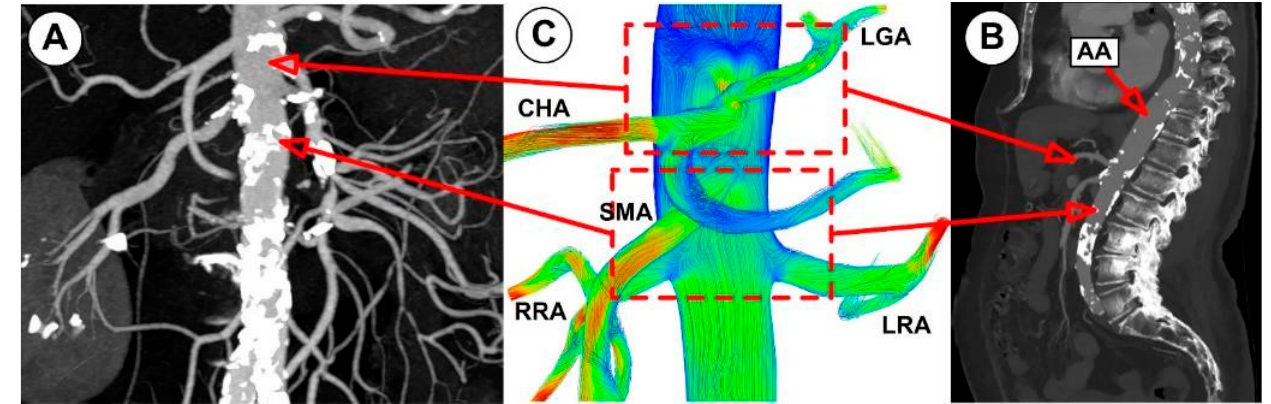
Figure 19. A CFD model was used to estimate the stenosis-prone area in the inferior aorta and its branches. ( A ) Anterior view of the inferior aorta segment with severe stenosis and calcification (patient A; ( B ) lateral view of the stenosed abdominal aorta (patient B); ( C ) flow field evolution predicted using numerical simulation in the region of the renal artery bifurcation. The CFD results (obtained for a healthy patient) can estimate the sites prone to stenosis development in different segments of the abdominal aorta.